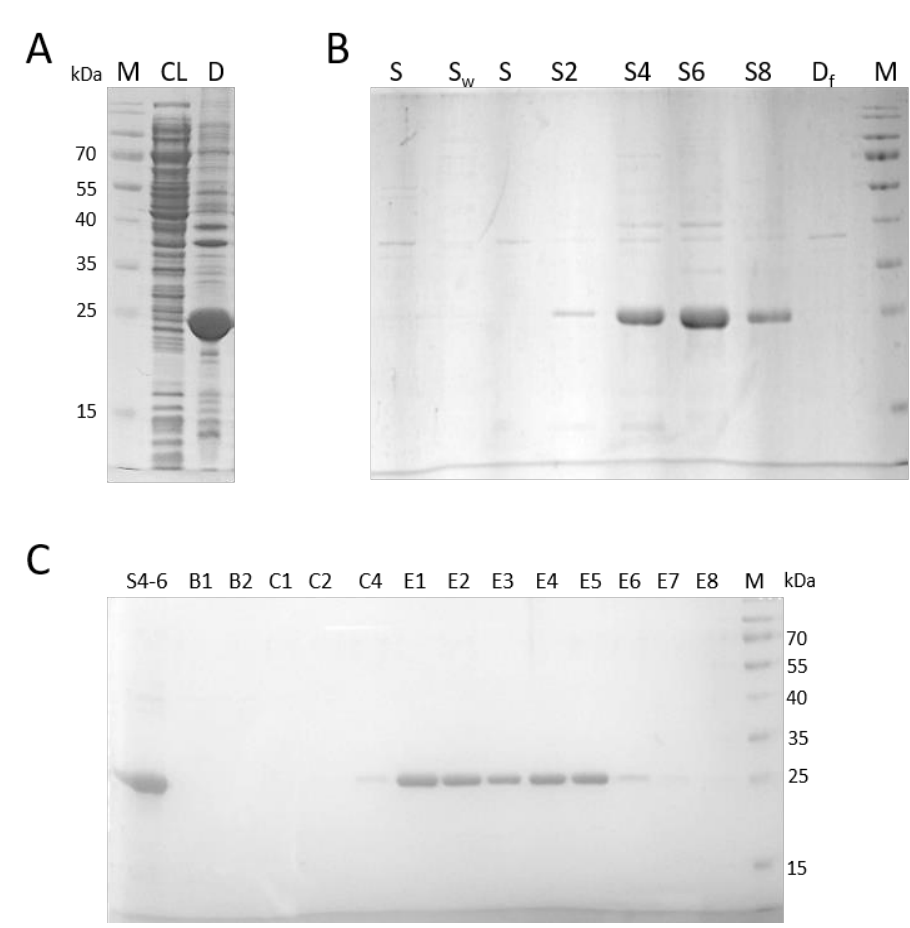
Figure 1. Purification of HlyIILCTD under denaturing conditions. ( A ) Analysis of HlyIILCTD expression in E. coli BL21 (DE3). M, protein marker; CL, clarified lysate; D, cell debris. ( B ) Analysis of protein solubility at different concentrations of urea. S, the supernatant after washing the debris with double distilled water; S w , the supernatant after washing the debris with buffer W; S2, the supernatant after washing the debris with 2 M urea; S4, the supernatant after washing the debris with 4 M urea; S6, the supernatant after washing the debris with 6 M urea; S8, the supernatant after washing the debris with 8 M urea; Df, residues of debris after all operations. M, protein marker.